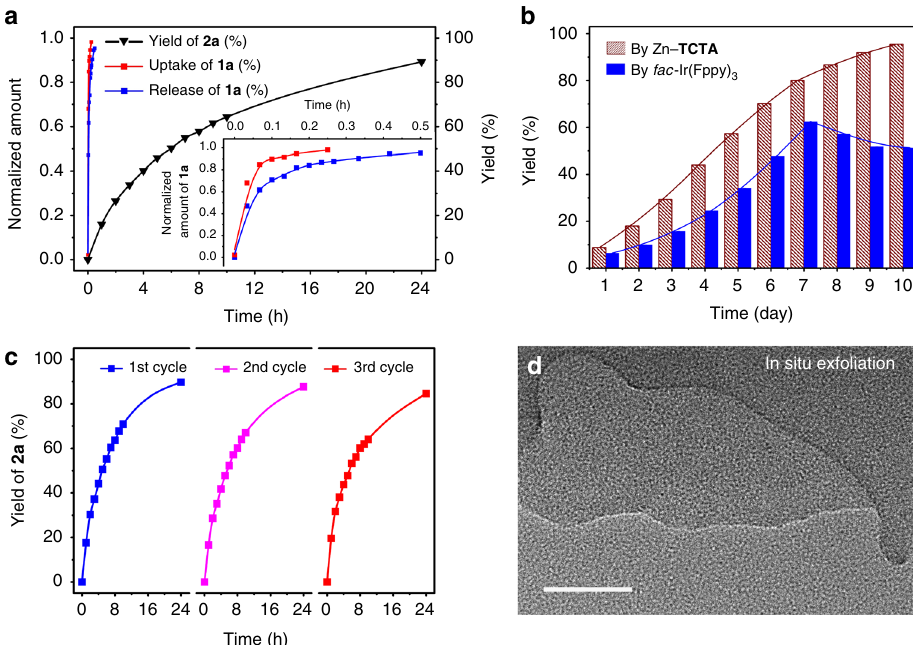
Fig. 4 Characterization of reaction dynamics and photocatalyst recyclability. a The kinetics of the ingress and egress of substrate 1a on Zn – TCTA block crystals in an acetonitrile suspension and the time-dependent conversion plots of the photocatalytic transformation with the insert showing the enlarged ingress/egress curves. b Histograms of the time-course reactions of excess 1a (2.5mmol, 10 equiv) in the presence of Zn – TCTA and fac -Ir(Fppy) 3 (6.25 μ mol, 2.5mol%) as photocatalysts, respectively. c Time-conversion plots of three rounds of the reaction using recycled catalyst Zn – TCTA . d A magni fi ed TEM image of a crystalline powder of the photocatalyst Zn – TCTA after three rounds of reaction, showing the step-like cross-section of the laminated thin layers (inset, scale bar,